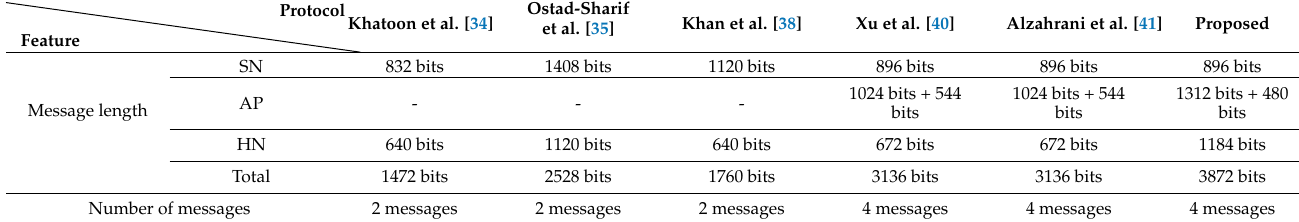
Table 4. Communication cost comparison result.